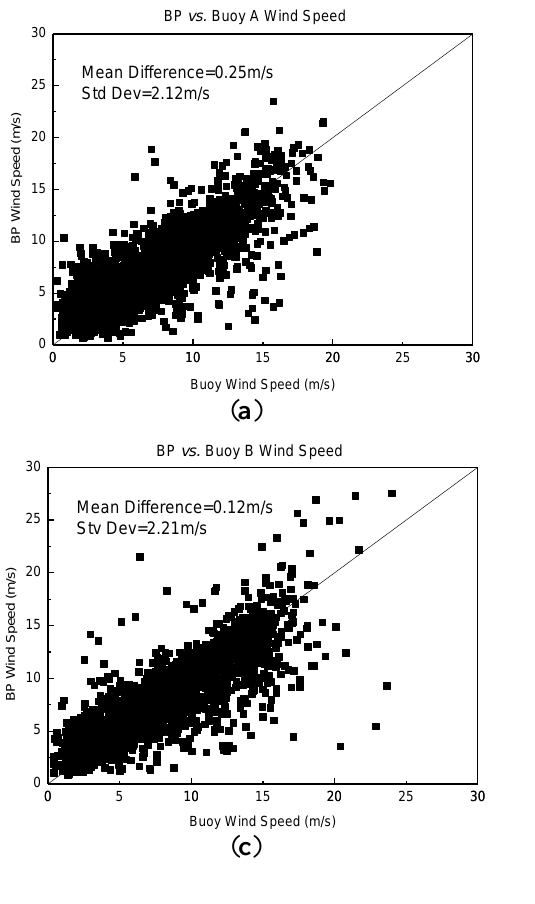
Figure 3. ( a ) BP vs. Buoy A-estimated wind speeds. ( b ) Reconstructed vs. Buoy A-estimated wind speeds. ( c ) BP vs. Buoy B-estimated wind speeds. ( d ) Reconstructed vs. Buoy B-estimated wind speeds. ( e ) BP vs. Buoy C-estimated wind speeds. ( f ) Reconstructed vs. Buoy C-estimated wind